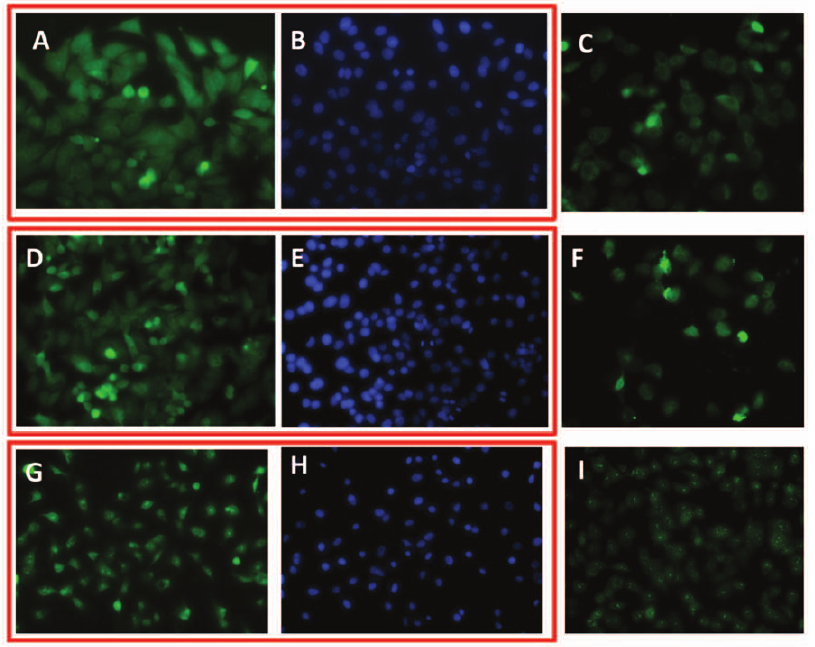
Figure 8. Fluorescence microscopy images for compound 1 (5 m M concentration) in HepG2 cells. (A) 37 u C treated cells for 3.75 hours and then fixed and imaged; (B) DAPI stained cells shown in (A); (C) live cells treated with 1 for 3.75 hours at 37 u C and then imaged; (D) Cells were pre- cooled at 4 u C for 30 min and then treated with 1 for 3.75 hours and then washed, fixed and imaged; (E) DAPI stained cells shown in (D); (F) Live cells treated with 1 for 3.75 hours at 4 u C (as in D); (G) Cells pre-treated with 10 mM NaN 3 and 50 mM deoxy-D-glucose for 60 minutes and then with 1 for 3.75 hours and then washed, fixed and imaged; (H) DAPI stained cells shown in (G); (I) live cells treated with NaN 3 and deoxy-D-glucose (as in G).